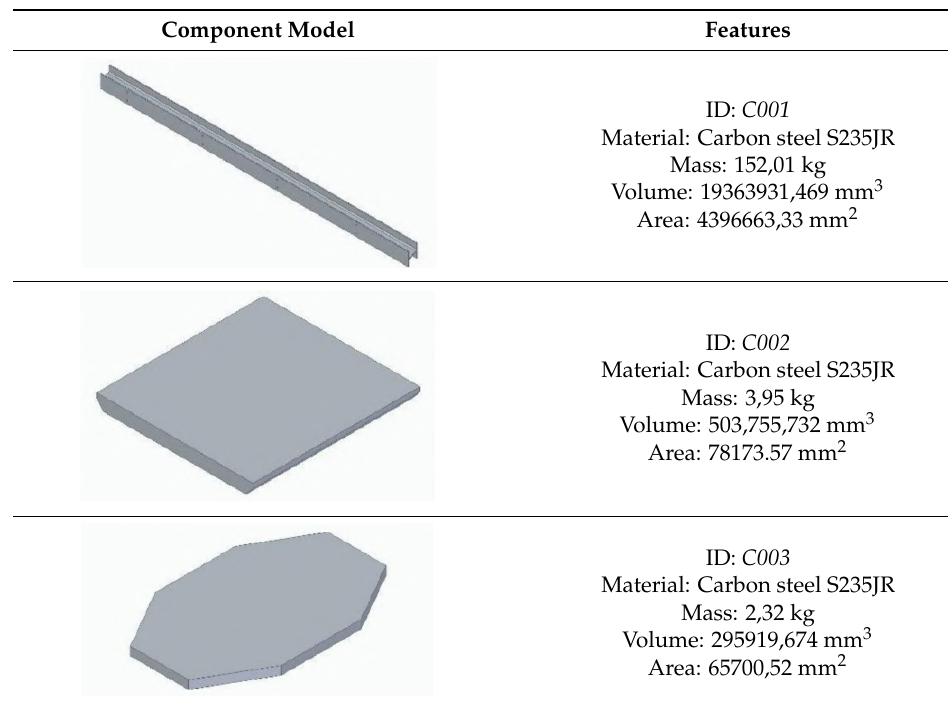
Table 5. Component features extracted by the 3D CAD model of the lateral